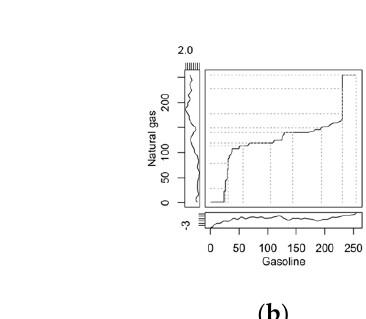
Figure 12. Alignment plots for gasoline and natural gas for the second subperiod. ( a ) Two-way, ( b ) Three-way. On the two-way plot the black solid line for gasoline, the red dashed line for natural gas. Source: own elaboration on the basis of data from www.stooq.com (accessed on 19 April 2021).